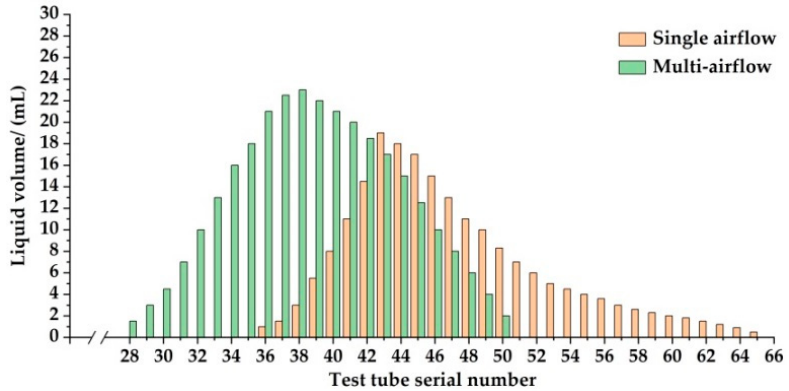
Figure 15. Distribution of droplet deposition in two states.